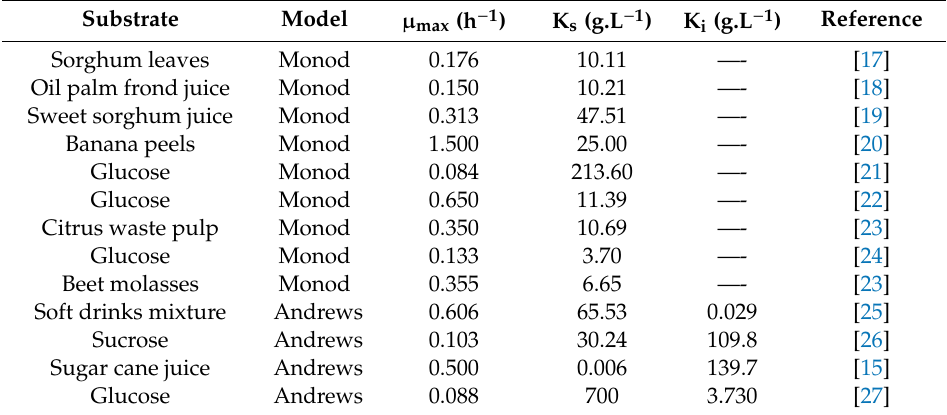
Table 1. The fermentation kinetics parameters of the Monod model using di ff erent